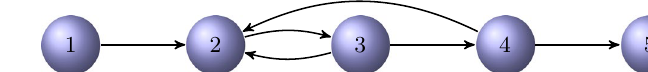
Fig. 2 A directed { 5,2 } -chained graph G with initial vertex v